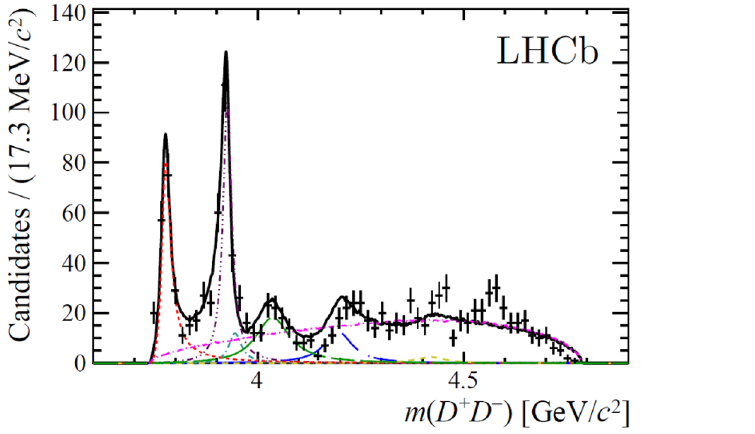
Figure 2 . The distribution over the invariant mass of D − D + in the decay B + → D + D − K + in the LHCb [1] data. The dots show the data, the curves show the resulting fit function and the contributions of the individual components of the